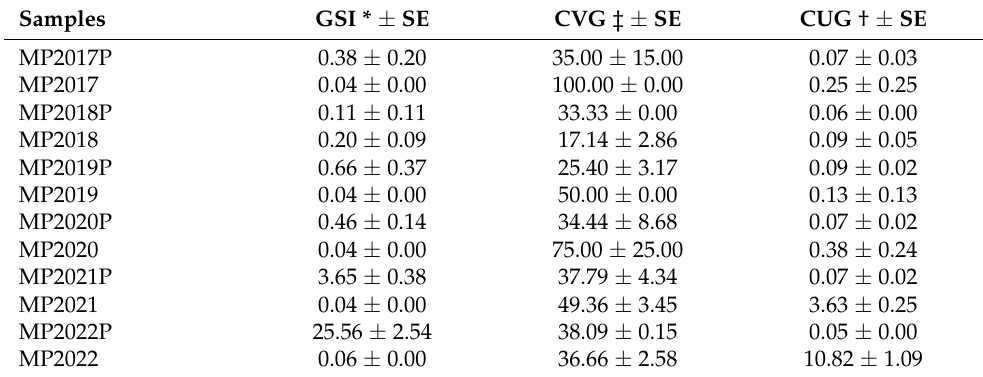
Table 3. Table of indices of seed